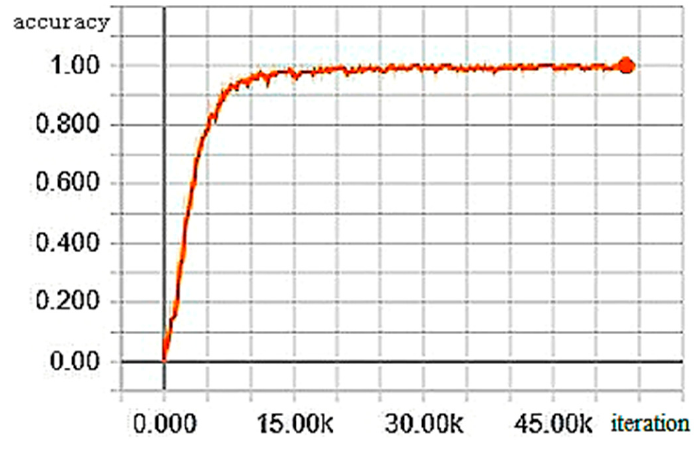
Figure 7. The training accuracy of the pedestrian image feature extraction network.